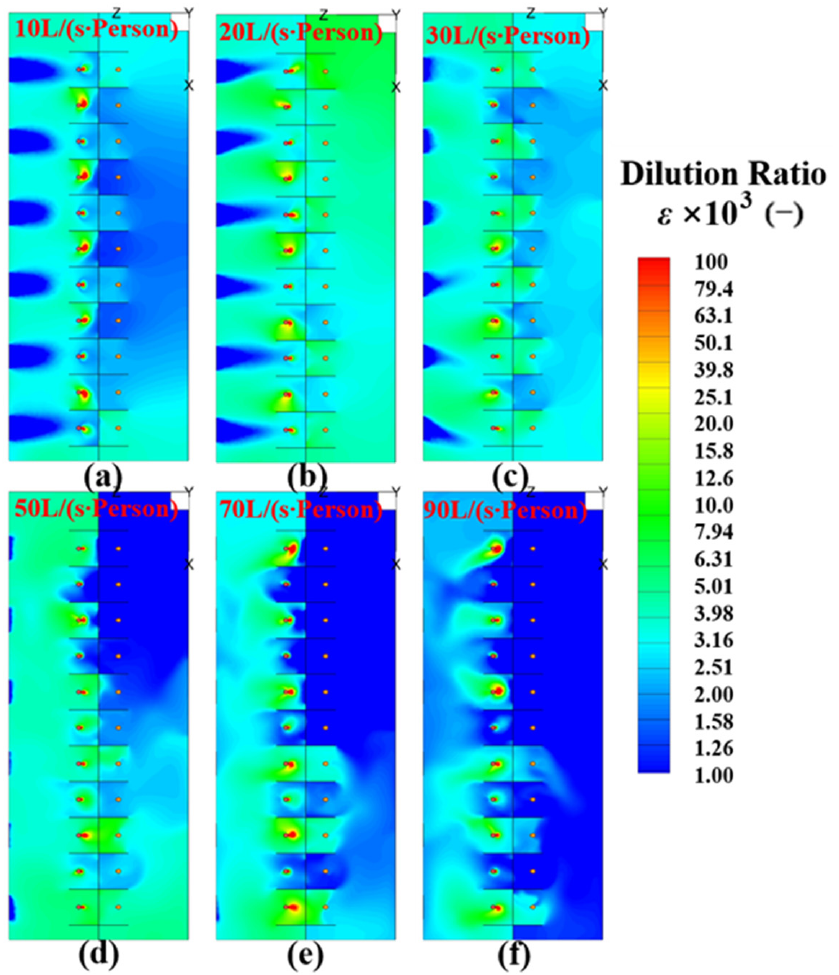
Figure 10. Dilution ratio distribution at the breathing height (y = 1.1 m) under the MSFV with different ventilation rates: ( a ) 10 L/(s · Person); ( b ) 20 L/(s · Person); ( c ) 30 L/(s · Person); ( d ) 50 L/(s · Person); ( e ) 70 L/(s · Person); ( f ) 90 L/(s · Person). For MEFV, the detailed ε distribution fluctuates as the ventilation rate increases, as shown in Figure 11, same with that in Figure 9. The ε at the breathing height in the MSZ was 9.7 × 10 − 3 with 10 L/(s · Person) and increased to 10.04 × 10 − 3 with 20 L/(s · Person). However, the ε was significantly reduced to 2.03 × 10 − 3 with 50 L/(s · Person), while in- creasing again as the ventilation rate was increased to 70 L/(s · Person). After the ventilation rate increased to 90 L/(s · Person), the ε dropped again. That means, the ε peaked when the ventilation flow rate was 20 L/(s · Person) and 70 L/(s · Person). When the ventilation rate was 20 L/(s · Person), the supply air jet entrained a large amount of air and created a backflow in the PZ zone, which may bring the exhaled pollutants back to the MSZ. When the ventilation rate was 70 L/(s · Person), the clockwise airflow induced by the supply air jet was strengthened. The airflow entered the PZ and blew towards the passengers, strengthening the lateral dispersion of exhaled pollutants, further increasing the probability of pollutants reaching the